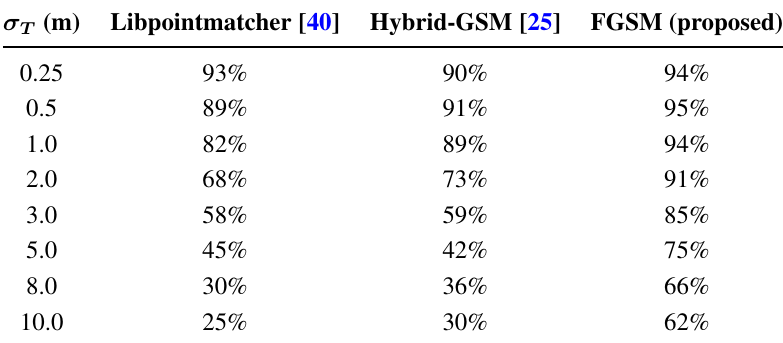
Table 1. A comparison of the proposed FGSM algorithm to previous methods in the case of translation only error. The percentage of trials that succeeded for various standard deviations in the translational component of the initial